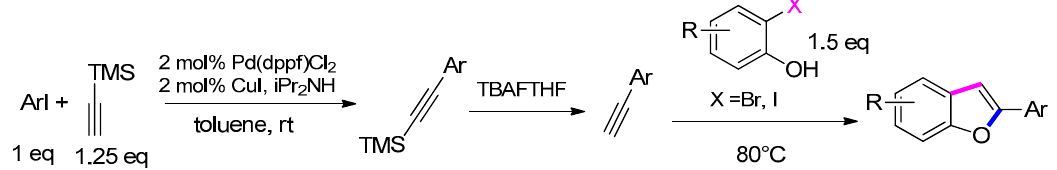
Scheme 47. Synthesis of benzofurans via multicatalytic system of o-halophenol and terminal